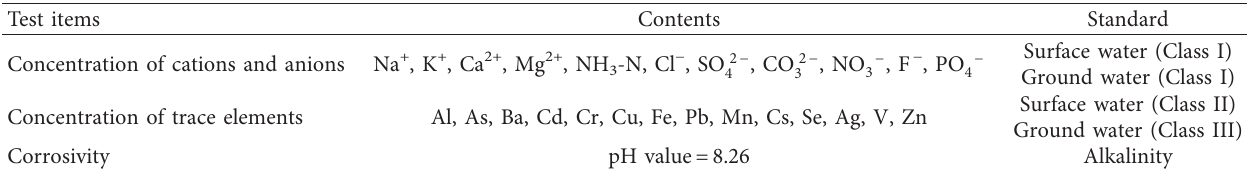
Table 6: Chemical composition analysis of SOF leachates.